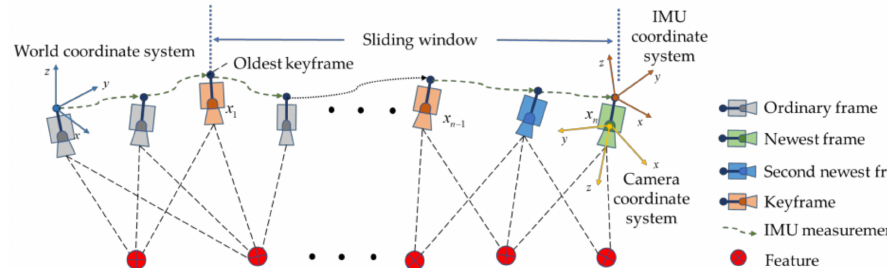
Figure 2. Observation model.